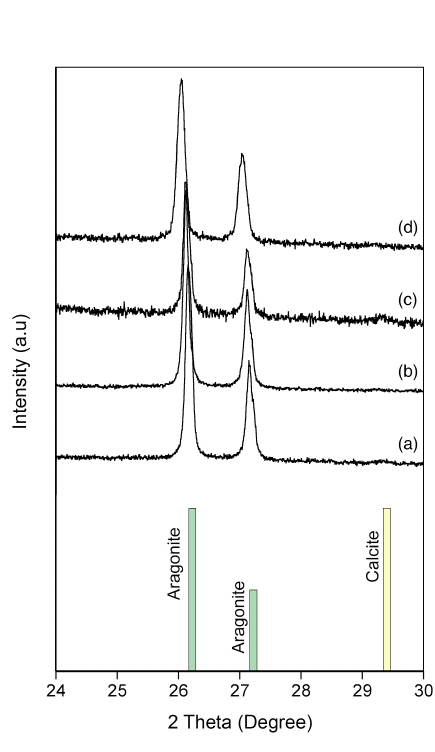
Figure 2. XRD patterns for Acropora spicifera coral recruit skele- tons grown under control (a) , high temperature (b) , high p CO 2 (c) and high temperature + p CO 2 (d) conditions. Aragonite standard peaks occur at 26.2 and 27.2 ◦ (green bars), and the calcite standard peak occurs at 29.4 ◦ (yellow